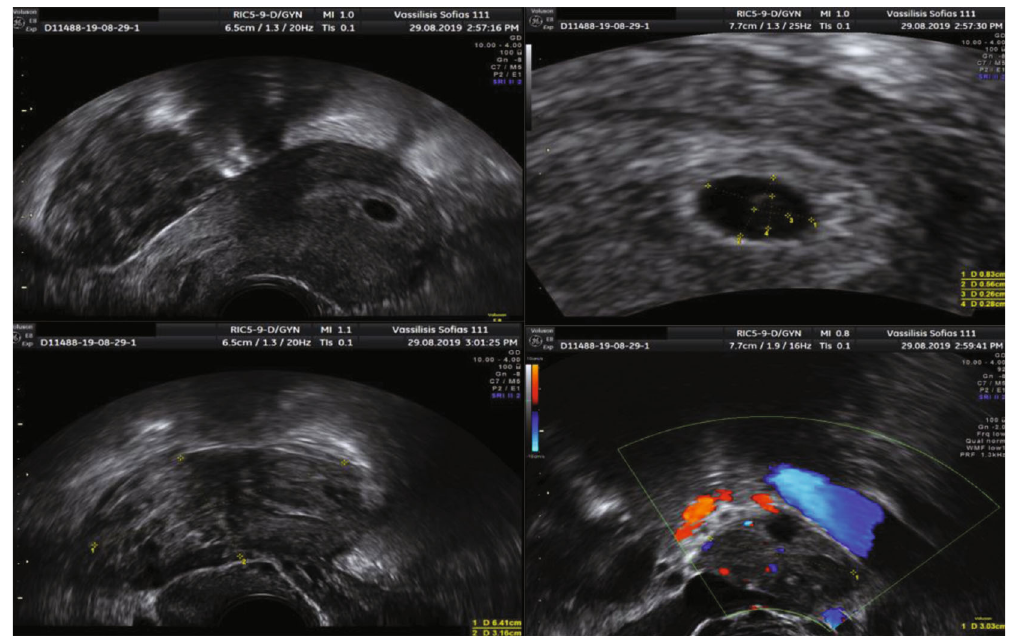
Figure 1: Hypoechoic mass in the right fallopian tube/adnexa with minimal blood fl ow on Doppler scan and illustration of the intrauterine